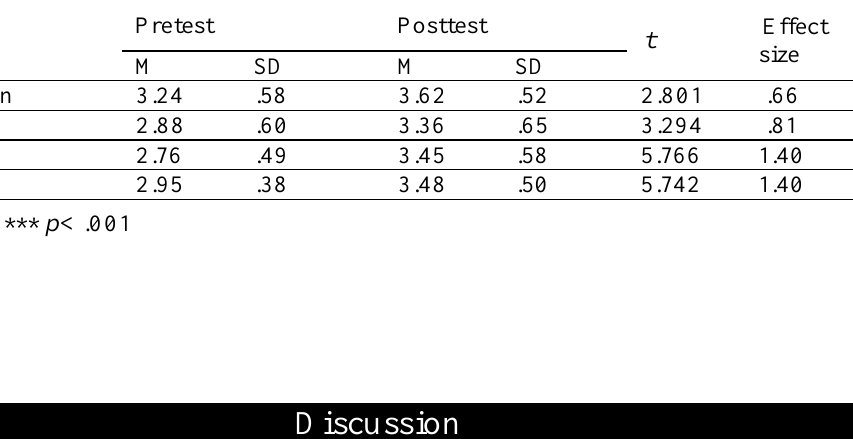
Paired-Samples t-Test on Self-Assessment Scores for the Experimental